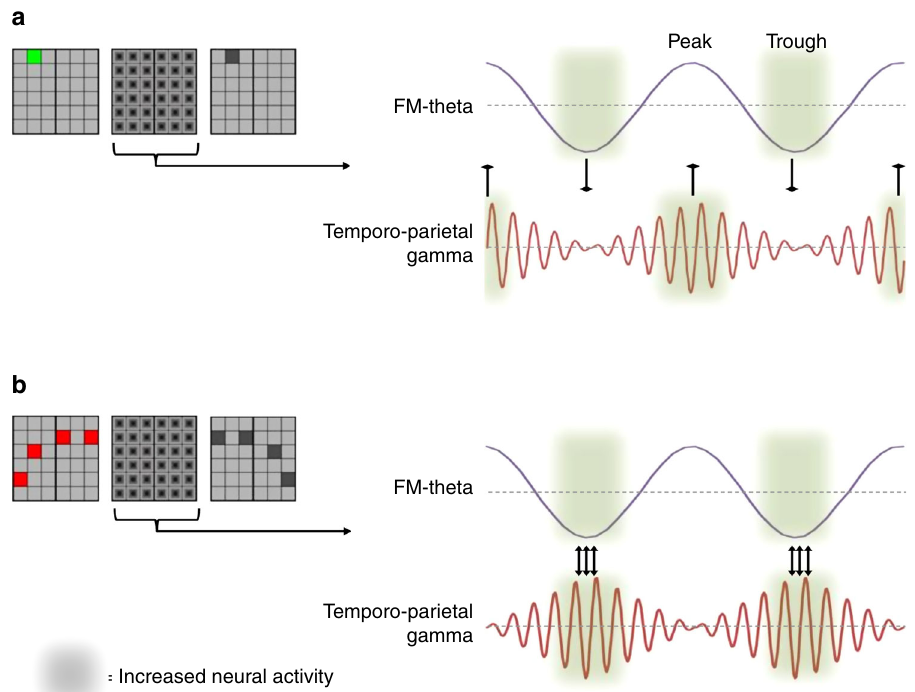
Fig. 3 Dynamic coupling and decoupling of fronto-parietal brain networks by phase-dependent nesting of gamma band activity into FM-theta waves. Schematic depiction of alignment of frontal and posterior neuronal activity by theta-gamma phase-amplitude coupling. a A fairly easy working memory process will not require deployment of large amounts of cognitive resources. Temporo-parietal cortex does not need to be coupled to fronto-medial cortex. Neuronal activity in frontal cortex is paced by FM-theta phase, with increased neuronal fi ring at the trough compared to the peak of the theta wave. Gamma activity is a signature of strong neuronal fi ring in temporo-parietal cortex. If posterior gamma activity is, thus, nested into the peak (the inhibitory phase) of FM-theta there will be un-simultaneous neural fi ring and therefore a state of decoupling within the fronto-parietal network. b A challenging working memory task such as the mental manipulation of four items will require maximal allocation of cognitive resources. Temporo-parietal cortex will need access to prefrontal cortex. This is achieved by alignment of frontal and posterior neural fi ring, enabled by nesting of posterior gamma activity into the excitatory trough of FM-theta phase. This will lead to effective coupling within the fronto-parietal network, with a dynamic adjustment of this neural synchronisation pattern dependent on cognitive resource allocation to the particular